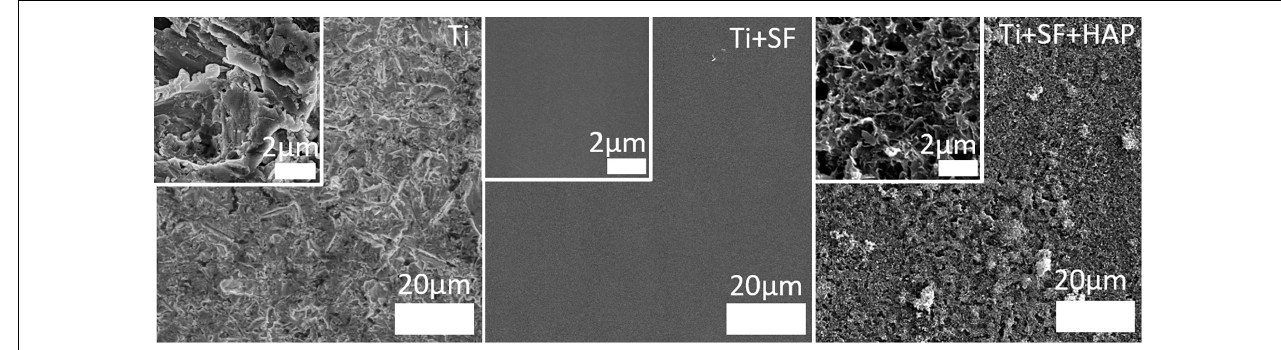
FIGURE 1 | SEM images of the three Ti samples: the Ti alloy substrate (Ti), coated SF Ti alloy (Ti + SF), and HAP/SF hybrid coated Ti alloy (Ti + SF + HAP). The inset images are locally magnified 10 × .